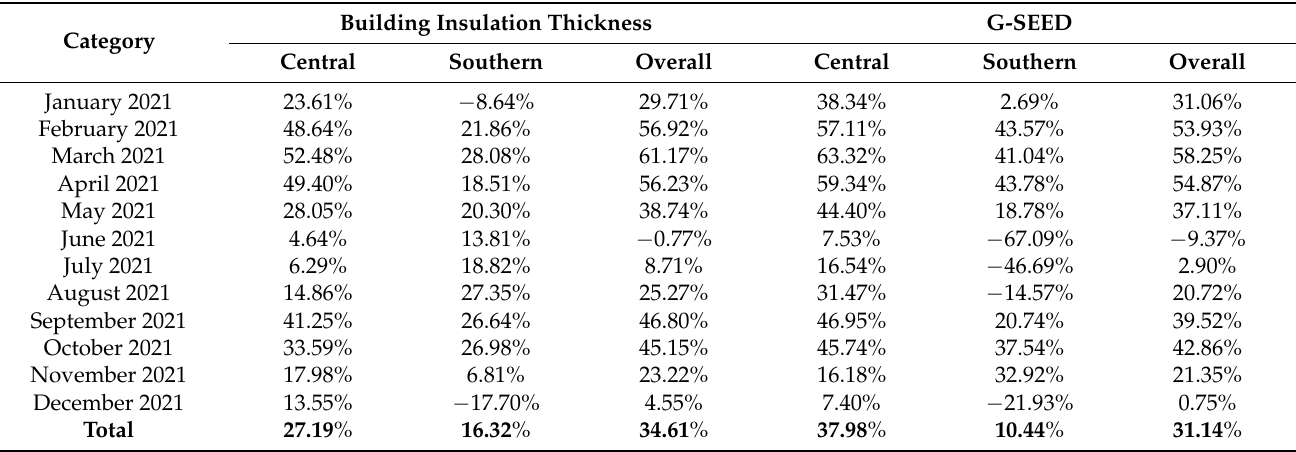
Table 10. Effectiveness of the revision of the building insulation thickness standard and G-SEED certification on energy consumption of courthouse